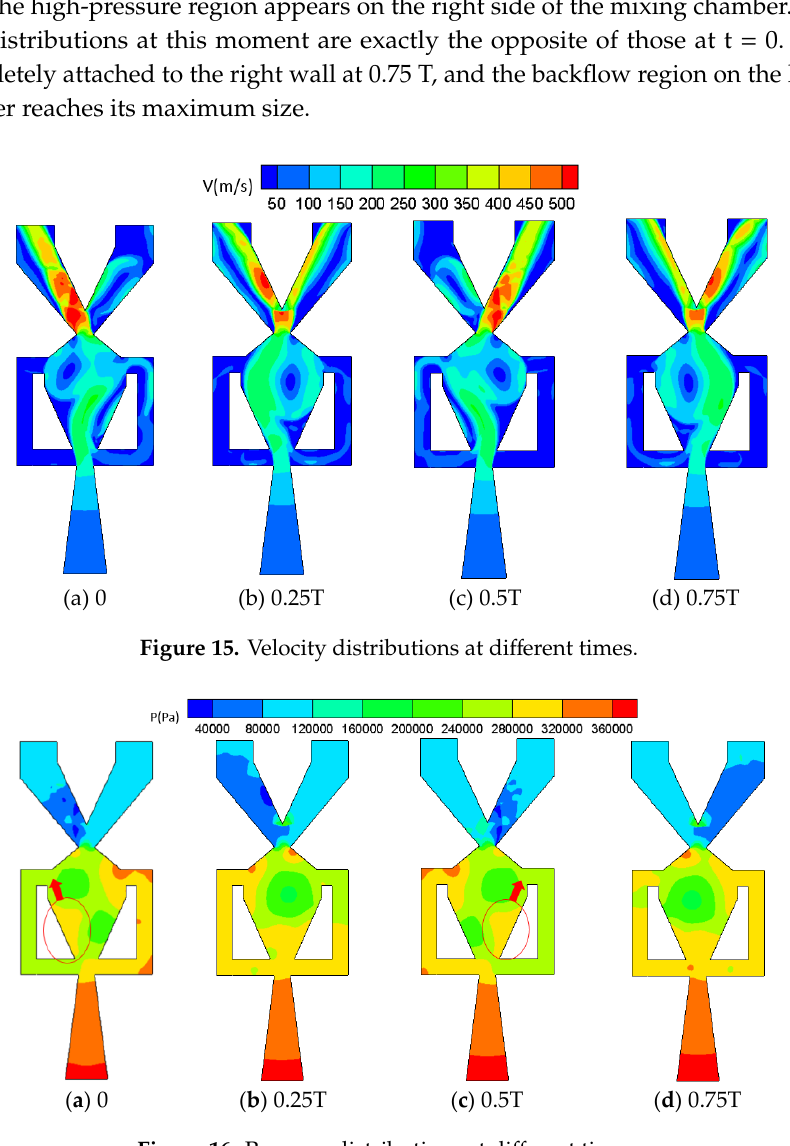
Figure 16. Pressure distributions at different times.